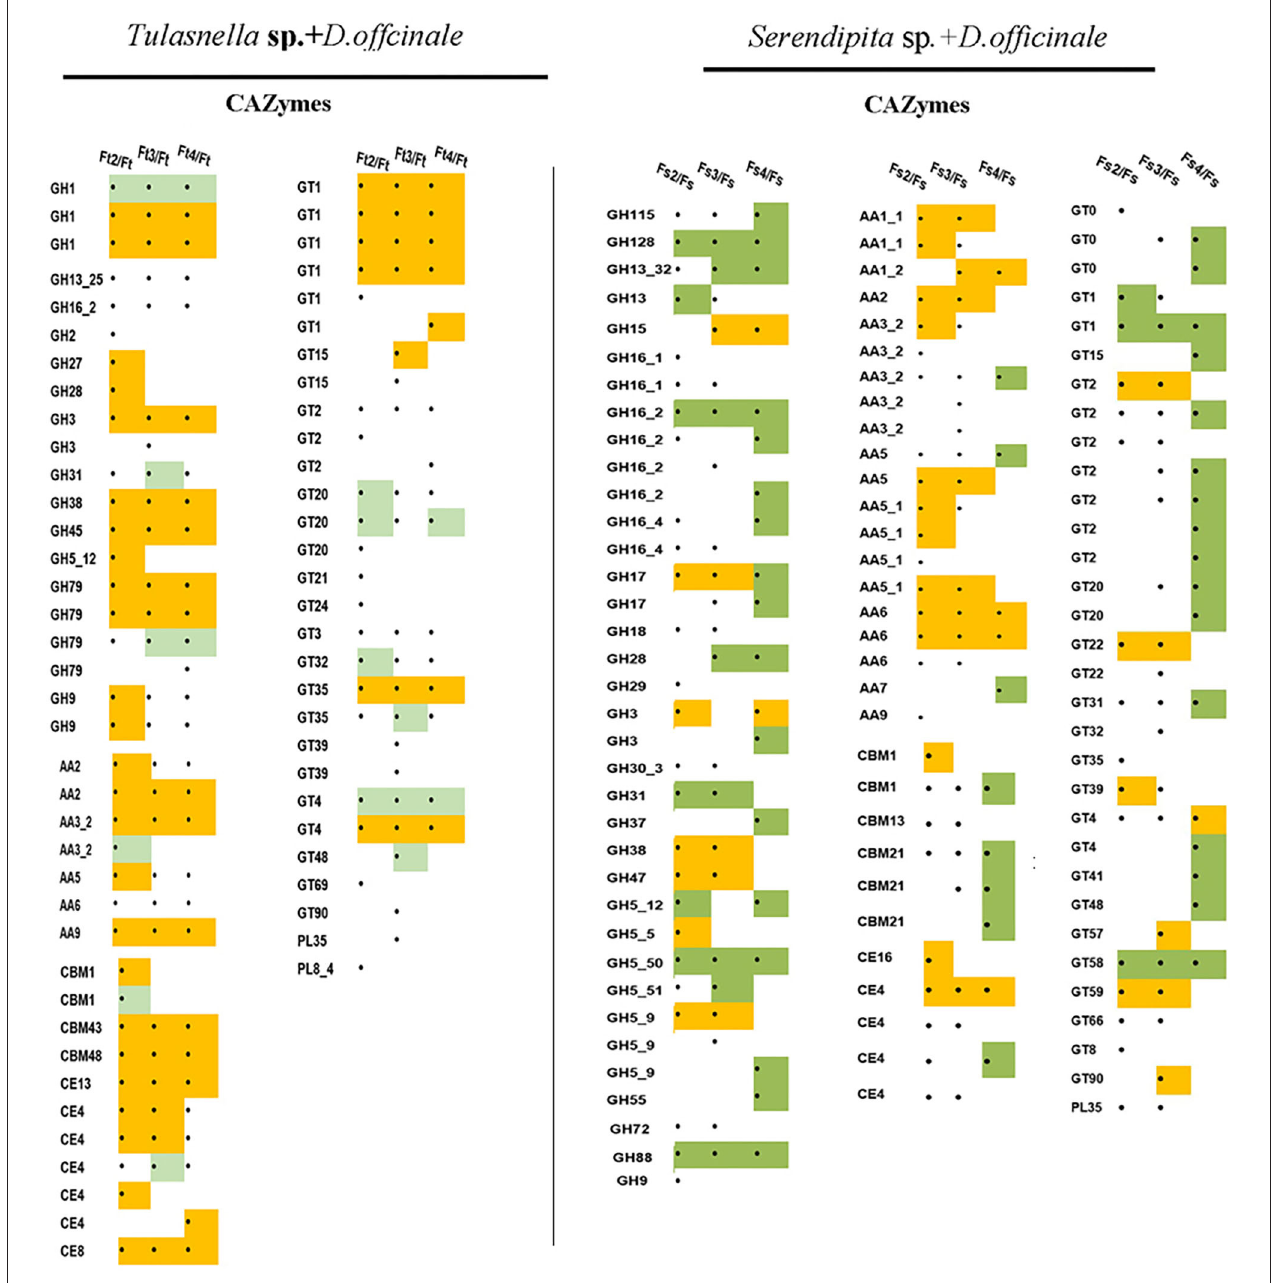
FIGURE 6 | Heatmap showing the expression profile of fungal DEGs encoding CAZyme proteins during symbiotic germination of D.officinale with Tulasnella sp. and Serendipita sp. • means genes differentially expression, blank means no significant differential expression; yellow color means genes up-regulated with fold change ≥ 5 and green color means genes down regulated with fold change ≥ 5. Ft2, Ft3, and Ft4 represent Tulasnella sp. in symbiotic statuses 2, 3, 4 stages while Fs2, Fs3, and Fs4 represent Serendipita sp. in symbiotic statuses 2, 3, and 4 stages (according to germination stage) and Ft and Fs means free-living mycelium of Tulasnella sp. and Serendipita sp.,